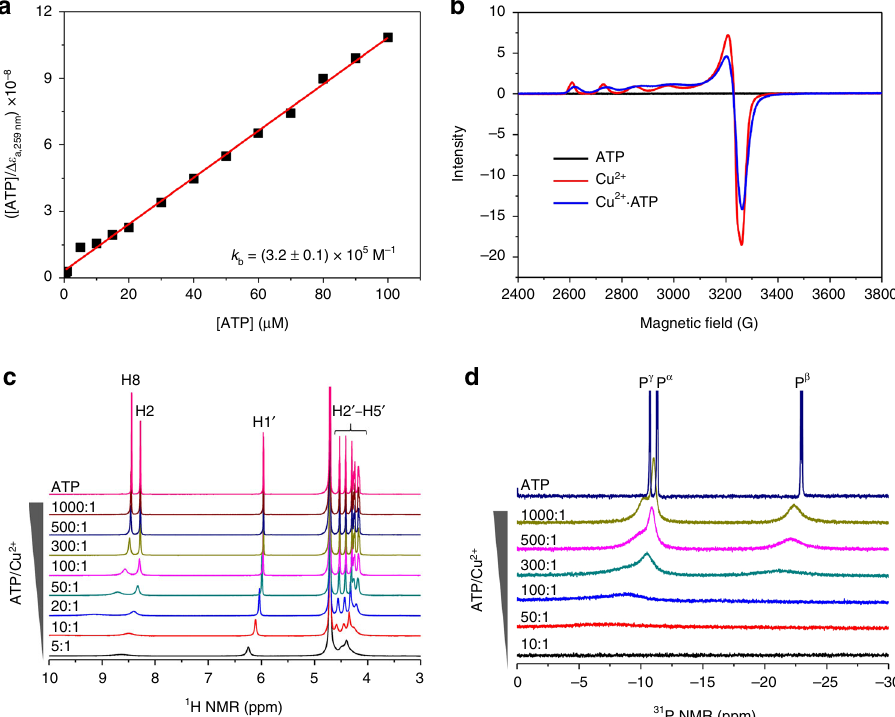
Fig. 3 The interaction between ATP and Cu 2 + ions. a The apparent binding constant ( k b ) of ATP and Cu 2 + ions derived from the plot of [ATP]/ Δ ε a,259 nm vs. [ATP] at various concentrations (5 – 100 μ M) for Cu(OTf) 2 (5 μ M). b EPR spectra of ATP, Cu 2 + and Cu 2 + ·ATP. Experimental conditions: ATP (50 mM), Cu(OTf) 2 (10 mM), glycerol (20 v/v%), MES (20 mM, pH 5.5), 100 K. c 1 H NMR and d 31 P NMR spectroscopic titrations of ATP (120 mM) by varying the concentration of CuCl 2 (0.12 – 24 mM) in D 2